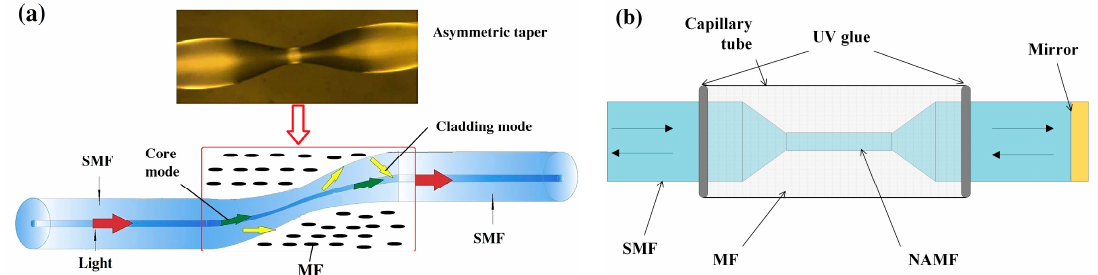
Figure 8. ( a ) Schematic of sensing probe based on tapered fiber immersed into MF [57] and ( b ) sensor probe based on non-adiabatic tapered optical fiber [62]; permission conveyed through the Copyright Clearance Center, Inc.